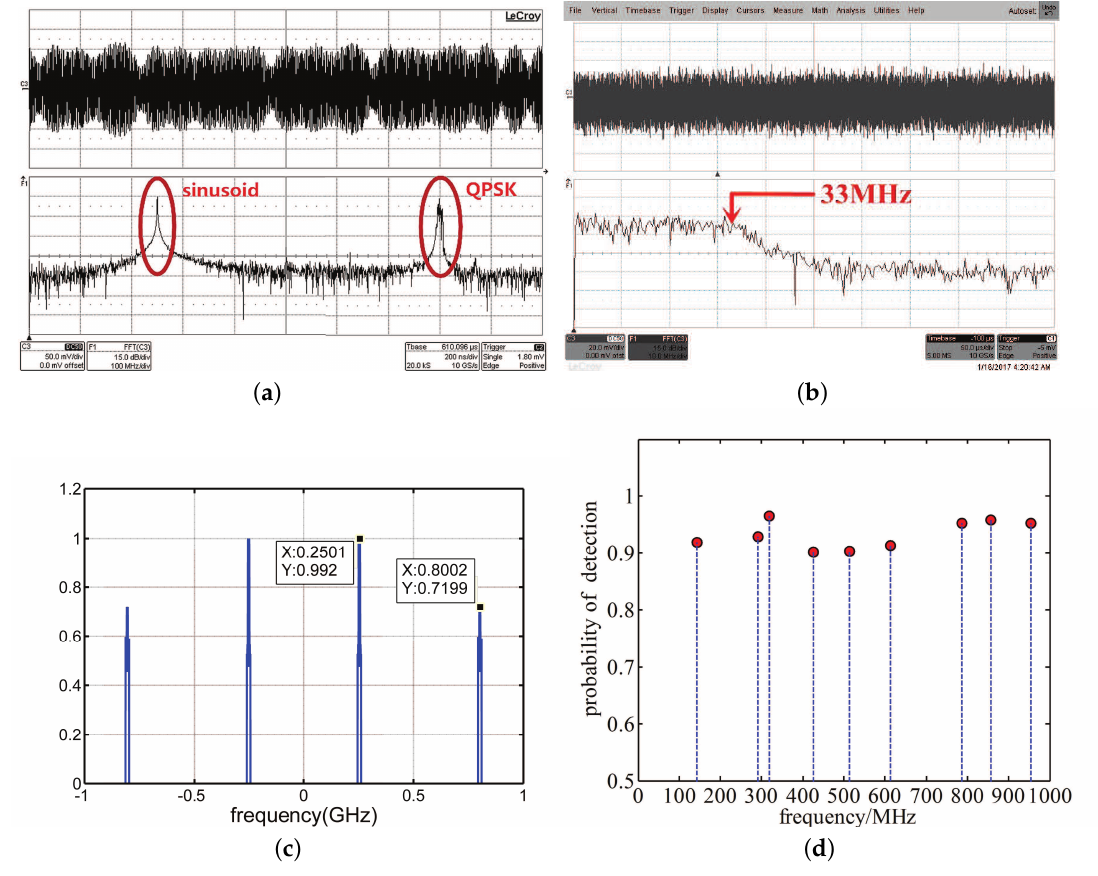
Figure 16. ( a ) The input signal and ( b ) Samples after LPF. ( c ) Detected power spectrum and ( d ) probability of